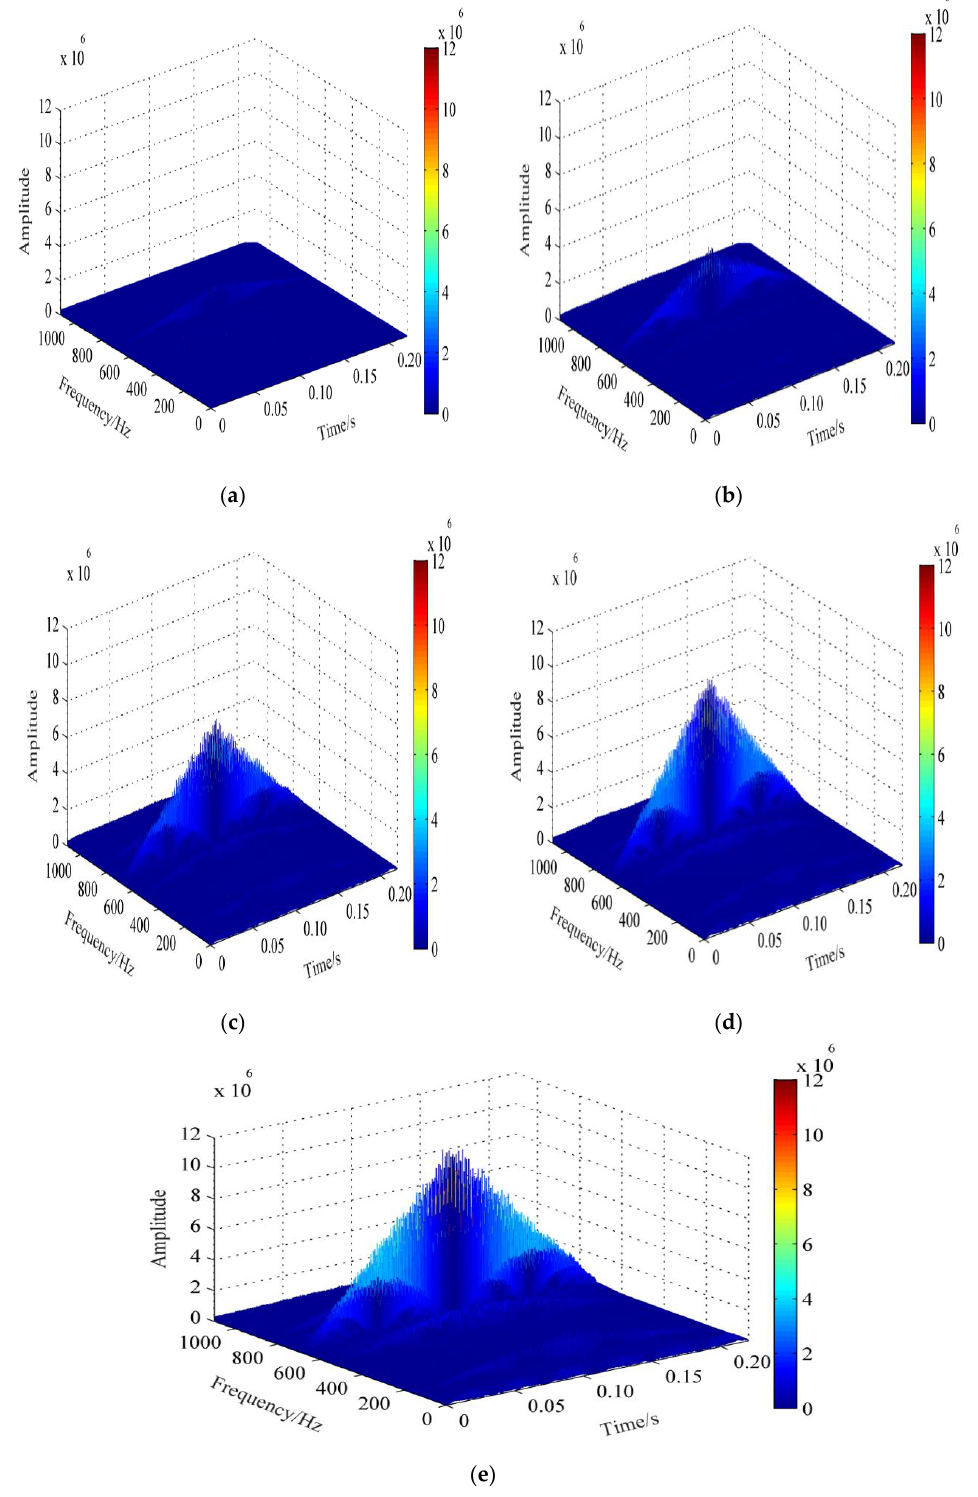
Figure 9. EEMD-WVD time-frequency-energy spectrograms corresponding to the axle-box acceleration caused by 24th-order polygonized wheels and for different OOR amplitudes: ( a ) OOR amplitude of0.04 mm; ( b ) OOR amplitude of0.06 mm; ( c ) OOR amplitude of0.08 mm; ( d ) OOR amplitude of0.10 mm; ( e ) OOR amplitude of0.12